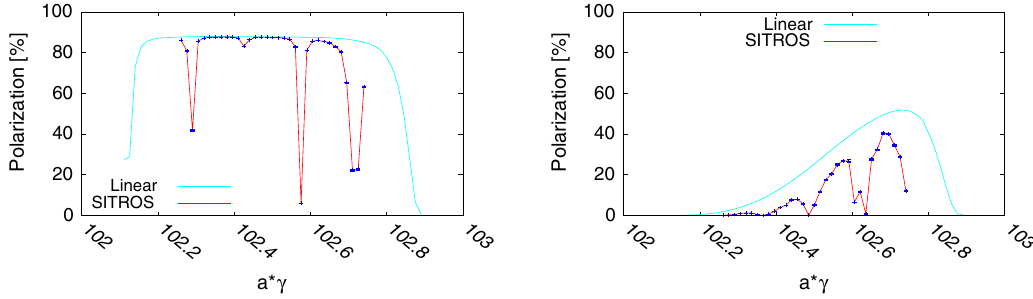
FIG. 13. 90 ° = 90 ° FODO. Left: Polarization vs. spin tune after orbit is corrected with 1096 correctors with δ Q y ¼ 200 μ m and w = o BPMs errors; 4 wigglers with B þ ¼ 0 . 7 T. Right: adding the BPMs errors.